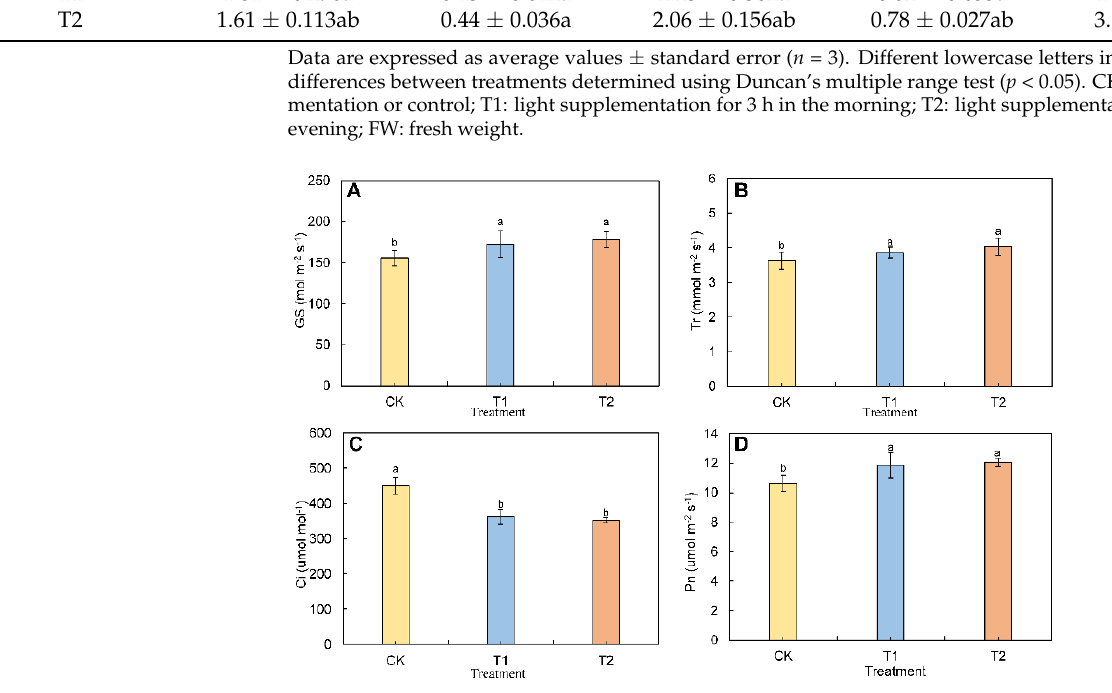
Figure 5. Stomatal conductance ( A ), transpiration rate ( B ), intercellular CO 2 concentration ( C ), and net photosynthetic rate ( D ) of tomato leaves exposed to different LED light supplementation durations. Data are expressed as average values ( n = 3). Different lowercase letters indicate significant differences between treatments determined using Duncan’s multiple range test ( p < 0.05). Bars indicate standard errors. CK: no light supplementation or control; T1: light supplementation for 3 h in the morning; T2: light supplementation for 3 h in the evening.